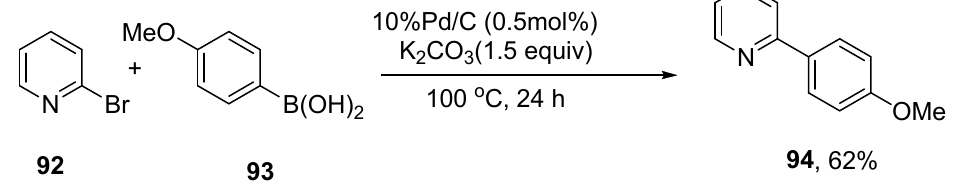
Scheme 16. Solvent-free Pd/C-catalyzed synthesis of 2-arylpyridine. A ligand-free Pd/C-catalyzed Suzuki–Miyaura reaction protocol for the coupling cy-